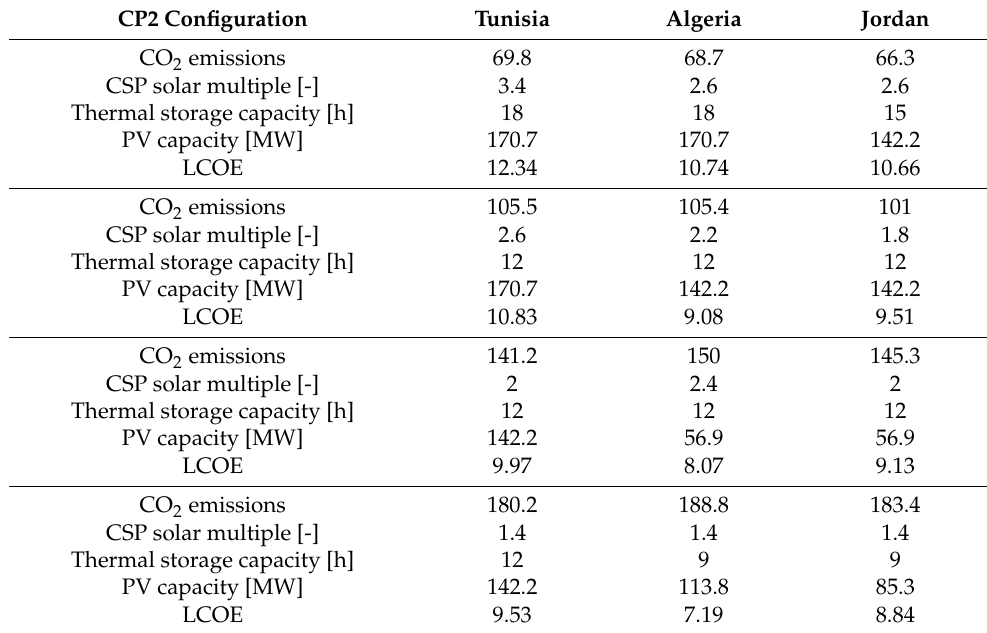
Table 7. Key results of LCOE optimization for CP2